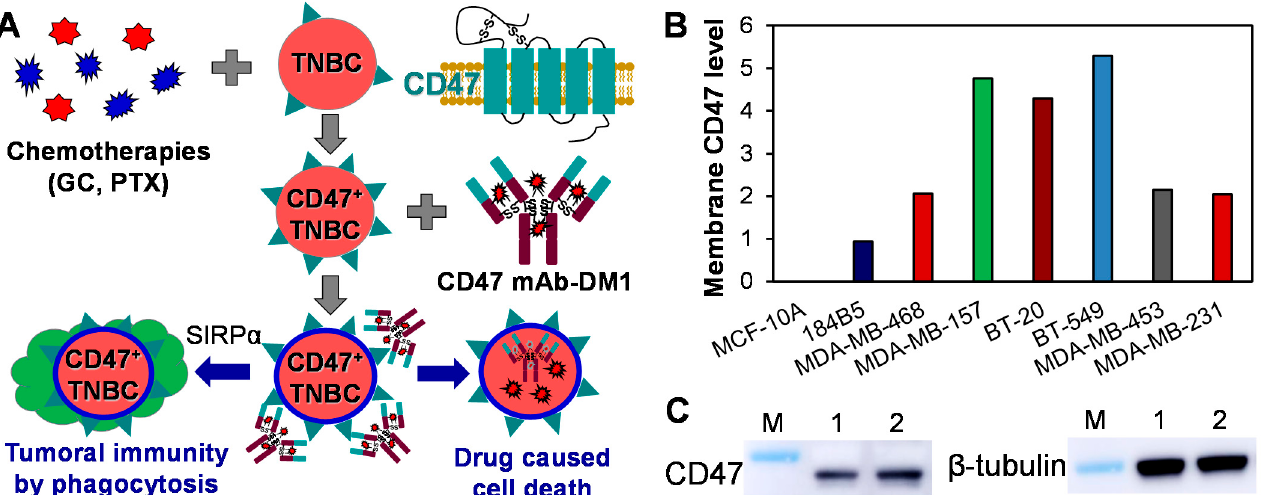
Figure 1. Surface receptor CD47 in TNBC. ( A ) Anti-TNBC mechanisms by targeting CD47-overexpressing TNBC cells to deliver payload with ADC and reactivating macrophage to induce phagocytosis-based TNBC cell death. ( B ) Relative expression of membrane CD47 receptor in normal breast cells (MCF-10A and 184B5) and TNBC cells (MDA-MB-468, MDA-MB-157, BT-20, BT-549, MDA-MB-453, and MDA-MB-231). The CD47 expression was analyzed using MS analysis and presented as peptide counts. ( C ) Western blotting analysis of CD47 in MDA-MB-231 cells (Lane: 1) and GC treated MDA-MB-231 cells (Lane: 2).